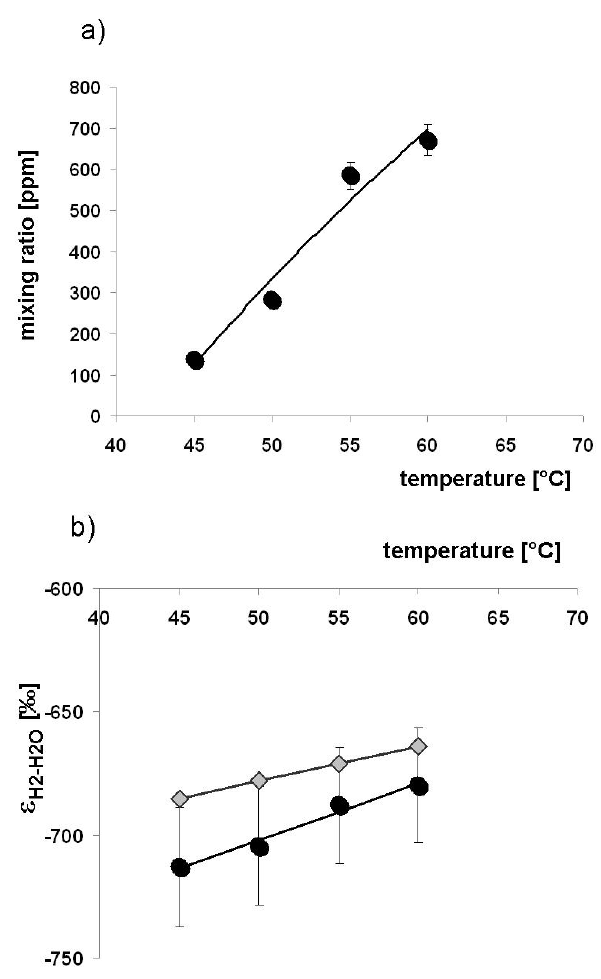
Figure 2: Fig. 2. Dependency of H 2 mixing ratio (a) and ε H 2 -H 2 O (b) on in- Figure 2: cubation temperature for continuous incubations from the biogas plant under otherwise identical conditions (substrate 30% grass, 30% maize, 40% cereals). Gray diamonds in figure (b) indicate the theoretically predicted value from Bottinga (1969). Results of the measured fit lines are: (a) y = 1990 ln(x) − 7453; R 2 = 0 . 96; (b) y = 2 . 3 x − 817 . 4; R 2 = 0 . 98. Note: With respect to enzymatic catalised production of hydrogen, a logarithmic fit is chosen for the relation between temperature and mixing ratio. Note: the error bars given are not representing the reproducibility of the duplicate mea- surements, but also take into account the general uncertainties by using mean relative errors of 2.9% for δD and 5.4% for the mixing